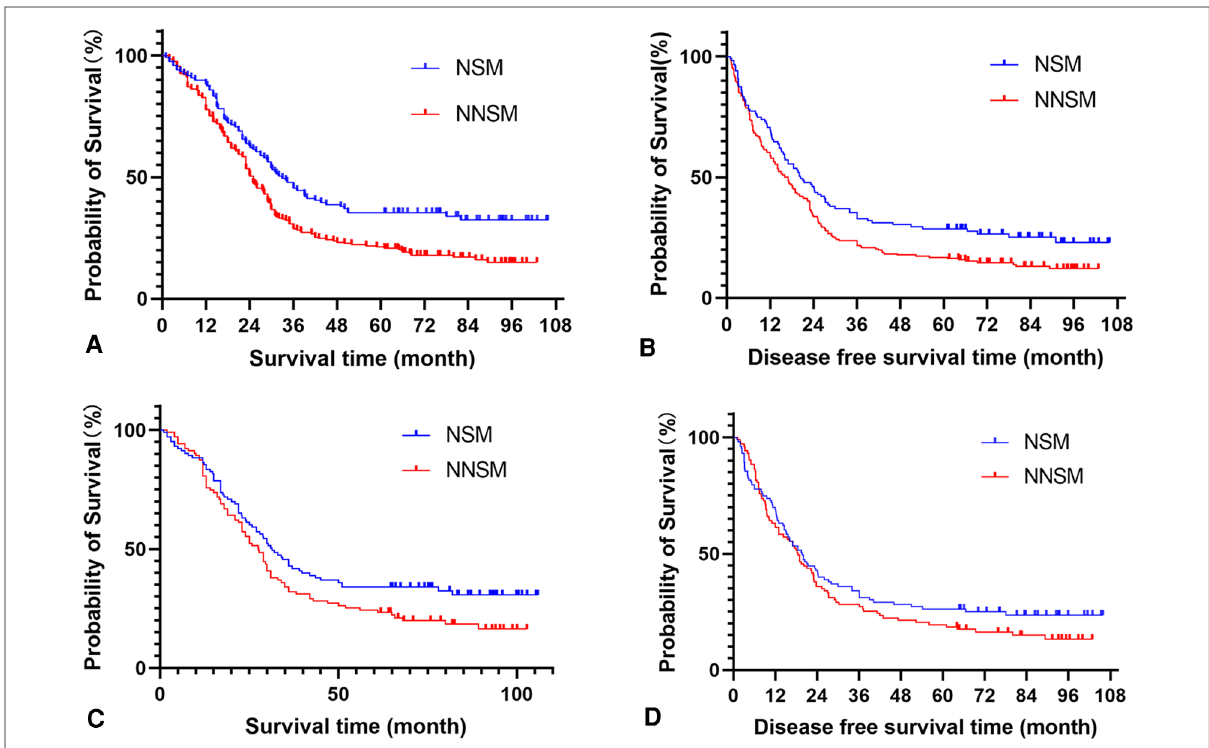
FIGURE 2 Analyse of patients survival and disease free survival time according the lymph node metastases status. ( A ) Survival analysis of all cohorts before propensity score matching. ( B ) Disease free survival analysis of all cohorts before propensity score matching. ( C ) Survival analysis of all cohorts after propensity score matching. ( D ) Disease free survival analysis of all cohorts after propensity score matching. Note: NSM: nodal skip metastasis; NNSM: no-nodal skip